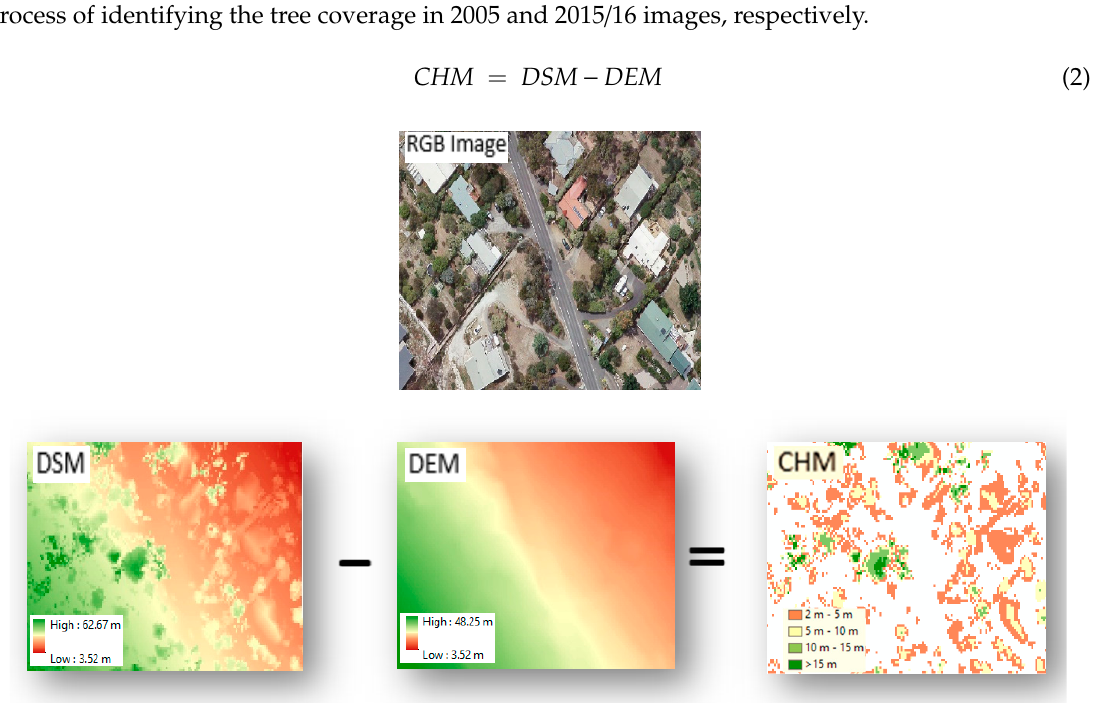
Figure 5. Canopy height model (CHM) generation from the digital surface model (DSM) and digital elevation model (DEM).